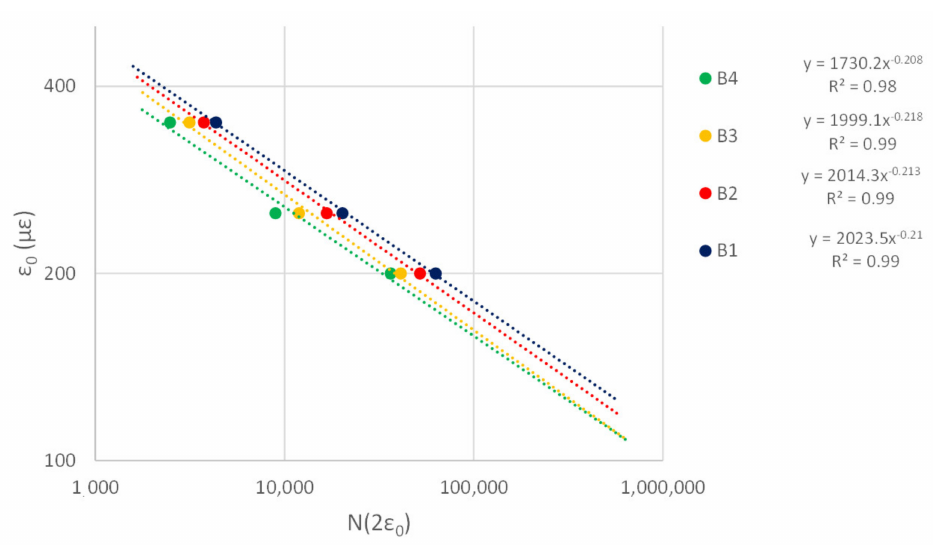
Figure 15. Fatigue curves—binder